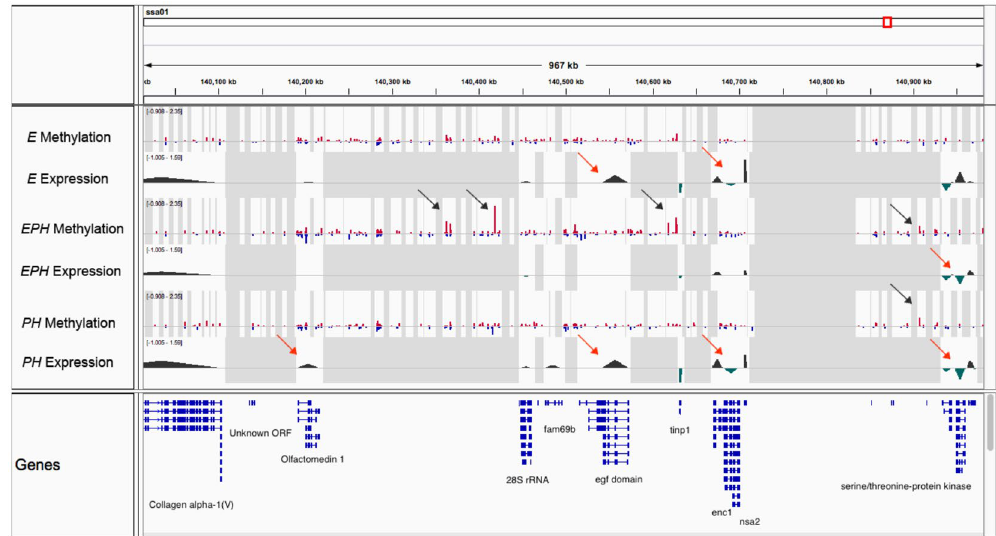
Figure 4. An example of a genomic bin on chromosome 1, showing suggestive association between differentially methylated sites with differentially expressed genes. The red and the blue bars show higher or lower levels of methylation relative to the control individuals in the stressed embryonic ( E ), post-hatch ( PH ) and embryonic and post-hatch ( EPH ) groups. The bars indicated by dark arrows are significantly hyper-methylated regions. The green peaks and valleys are log 2 fold-change differences in gene expression. The red arrows show genes that have been regulated differently compared to the un-stressed